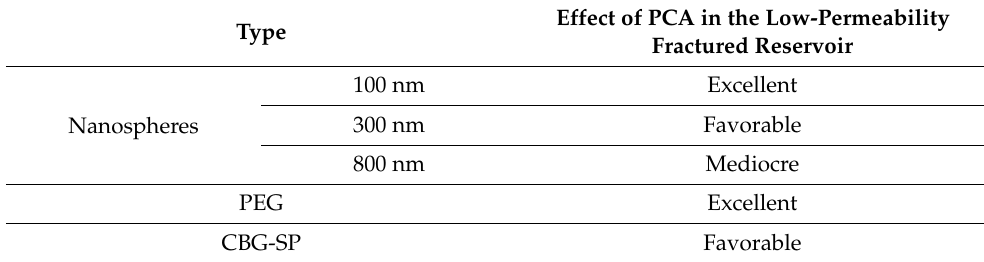
Table 12. Comparison between the effects of different